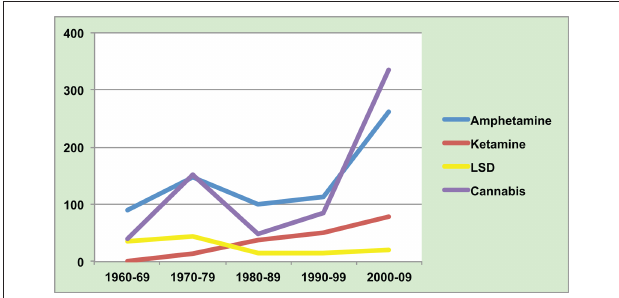
Figure 1 | Number of published papers (Pub Med) on illicit drugs and